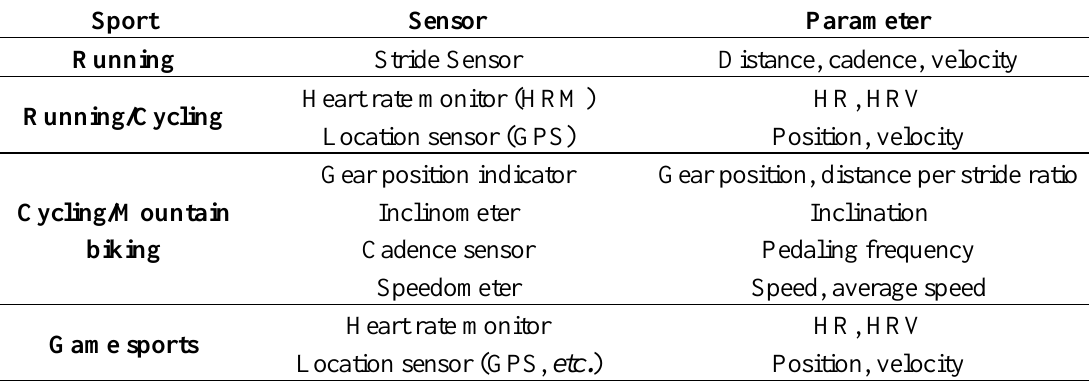
Table 3. Parameter/sensor combinations in selected sports ( cf.